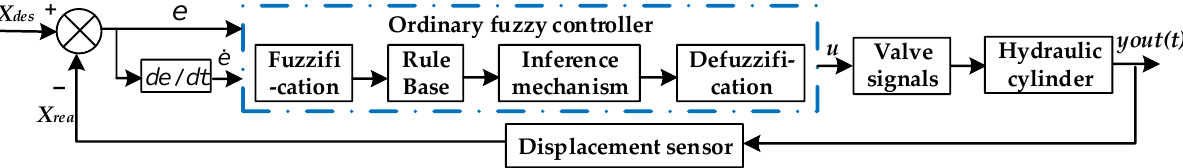
Figure 8. Block diagram of the ordinary fuzzy control system.